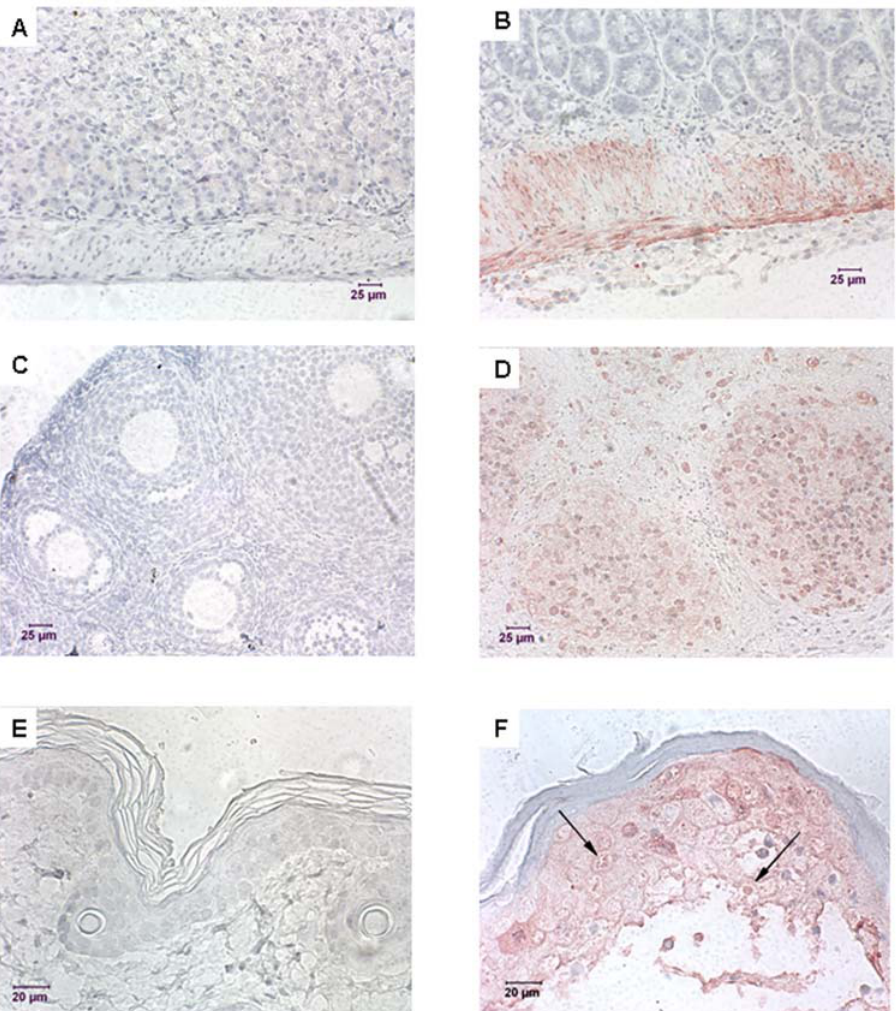
Figure 6. Immuno-histochemical staining in tissues of mice infected with MPXV. Tissues from 4-wk-old SCID/BALB/c mice infected IP with MPXV-USA-2003-Luc + and uninfected SCID/BALB/c mice were stained by using vaccinia mouse hyperimmune mouse and horse-radish peroxidase as a detection label. MPXV antigen was identified in the intestine, ovary and skin of the feet (7B, D, and F respectively). Poxviral inclusions were seen in the skin of a foot (7F arrows). MPXV antigen was also found in the nasal turbinate of IN infected mice (7H). None of the IHC-stained tissues of the control mice including intestine, ovary, and skin (7A, C, and E respectively) had viral antigen staining.